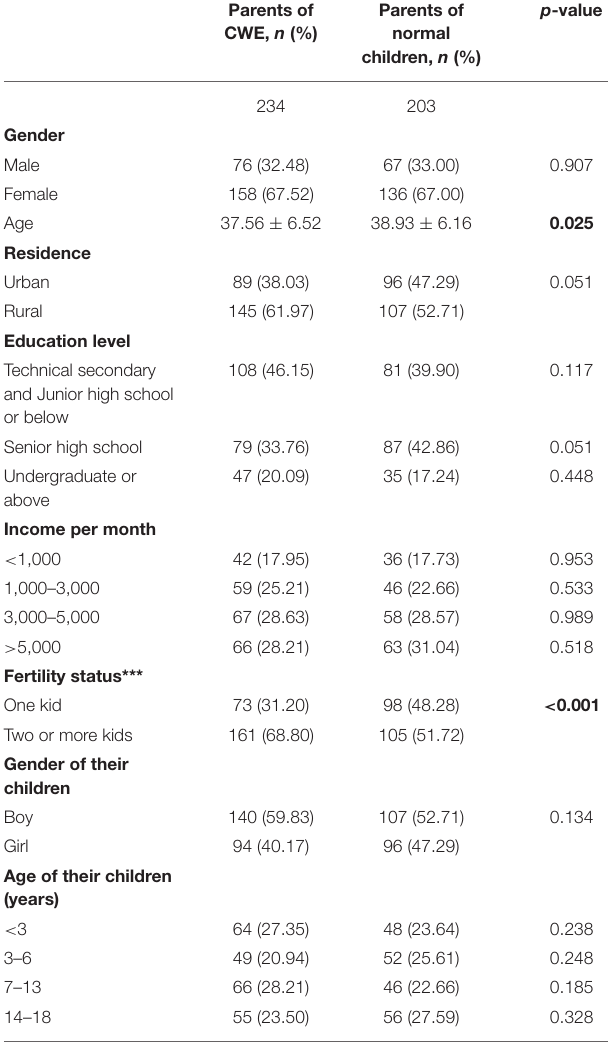
TABLE 1 | Demographic characteristics of the study